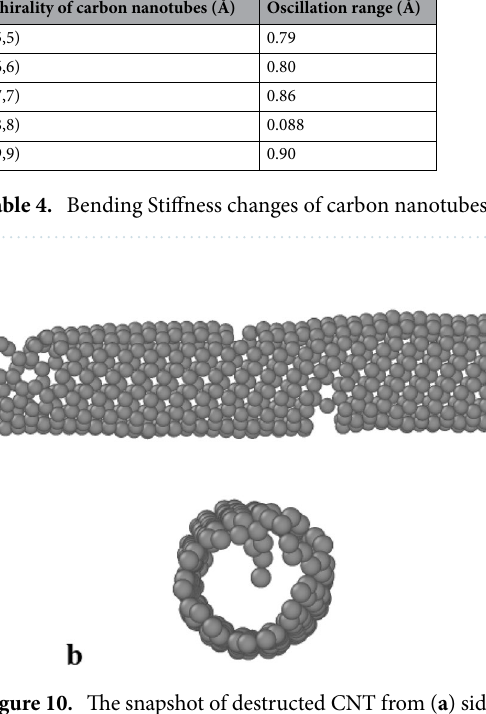
Figure 10. The snapshot of destructed CNT from ( a ) side and ( b ) top